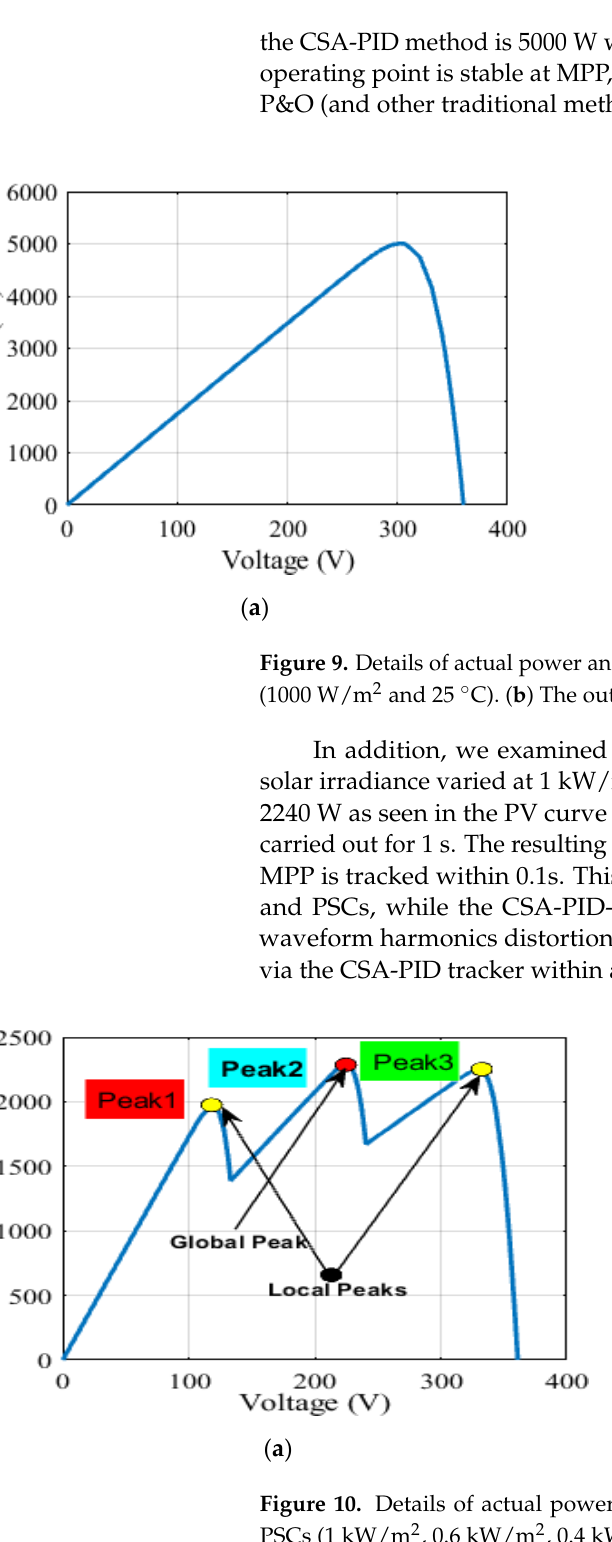
Figure 10. Details of actual power and proposed CSA-PID power under PSCs. ( a ) PV curve at PSCs (1 kW/m 2 , 0.6 kW/m 2 , 0.4 kW/m 2 , and 19 °C). ( b ) The output power of proposed CSA-PID under PSCs. under